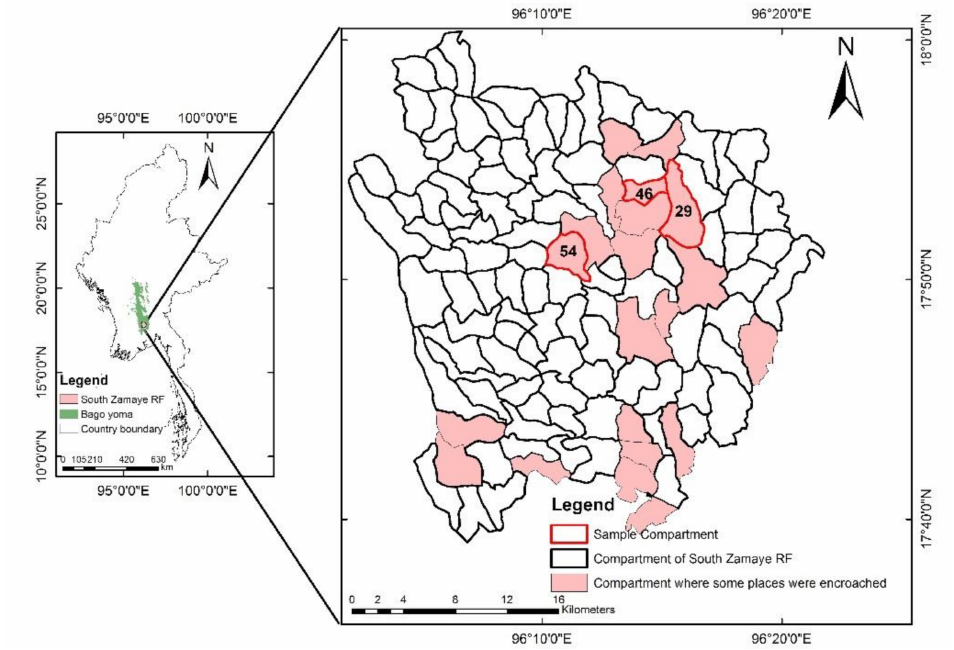
Figure 1. Location of study sites in South Zamaye Reserved Forest (RF), Bago Township,